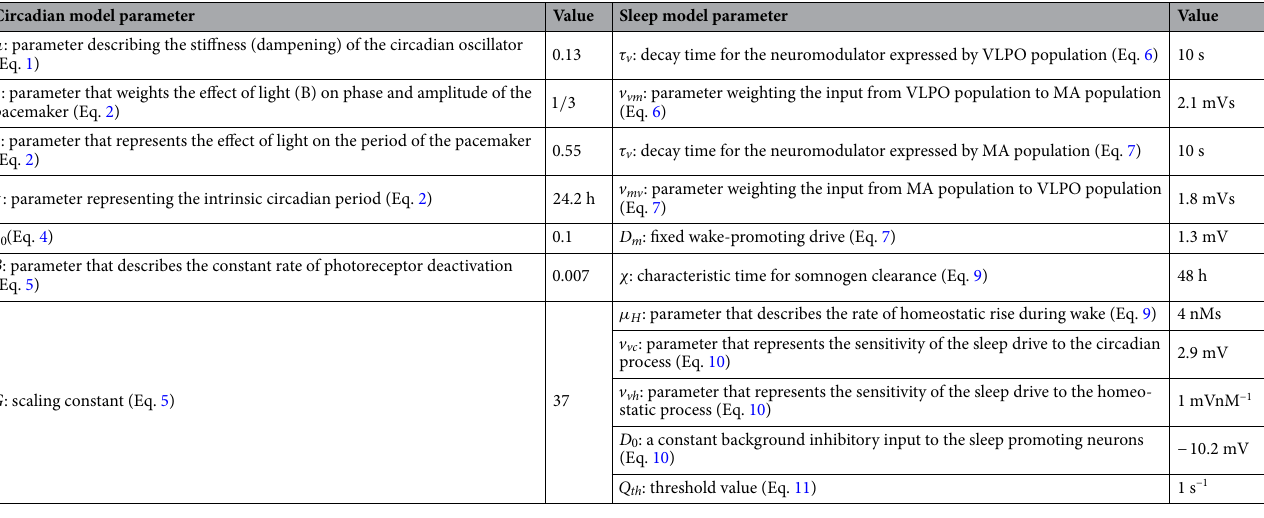
Table 1. Parameter values for the mathematical